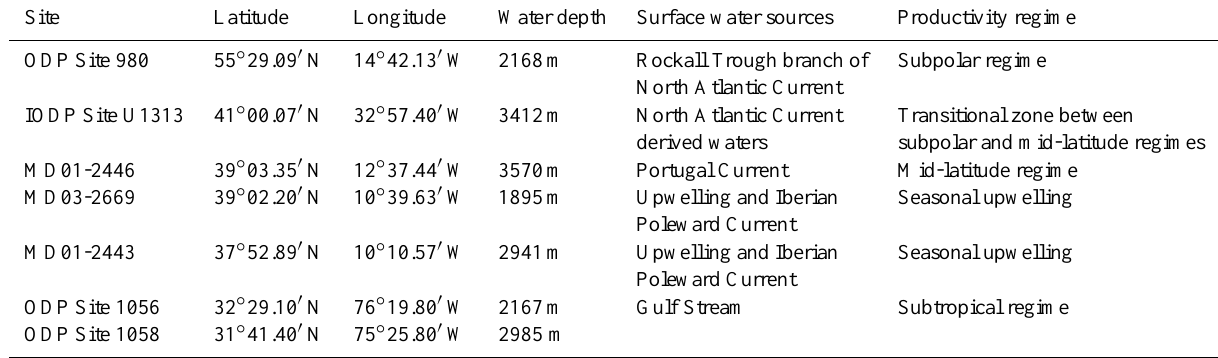
Table 1. Locations of core sites and their respective hydrographic and productivity